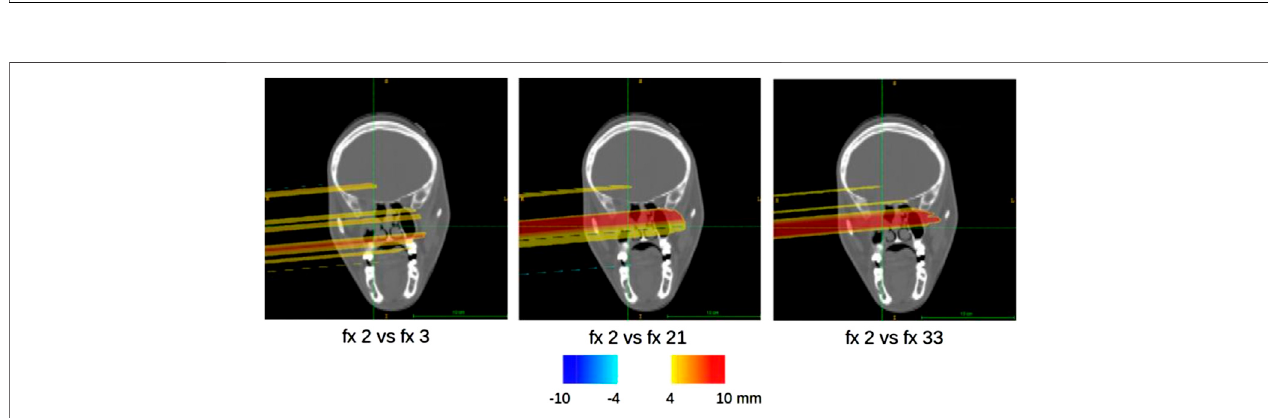
FIGURE 8 | Sample of compliance maps referring to the activity image analysis of different fractions (fx) of the 006P patient, overlaid on the planning CT with the proposed CLUT.